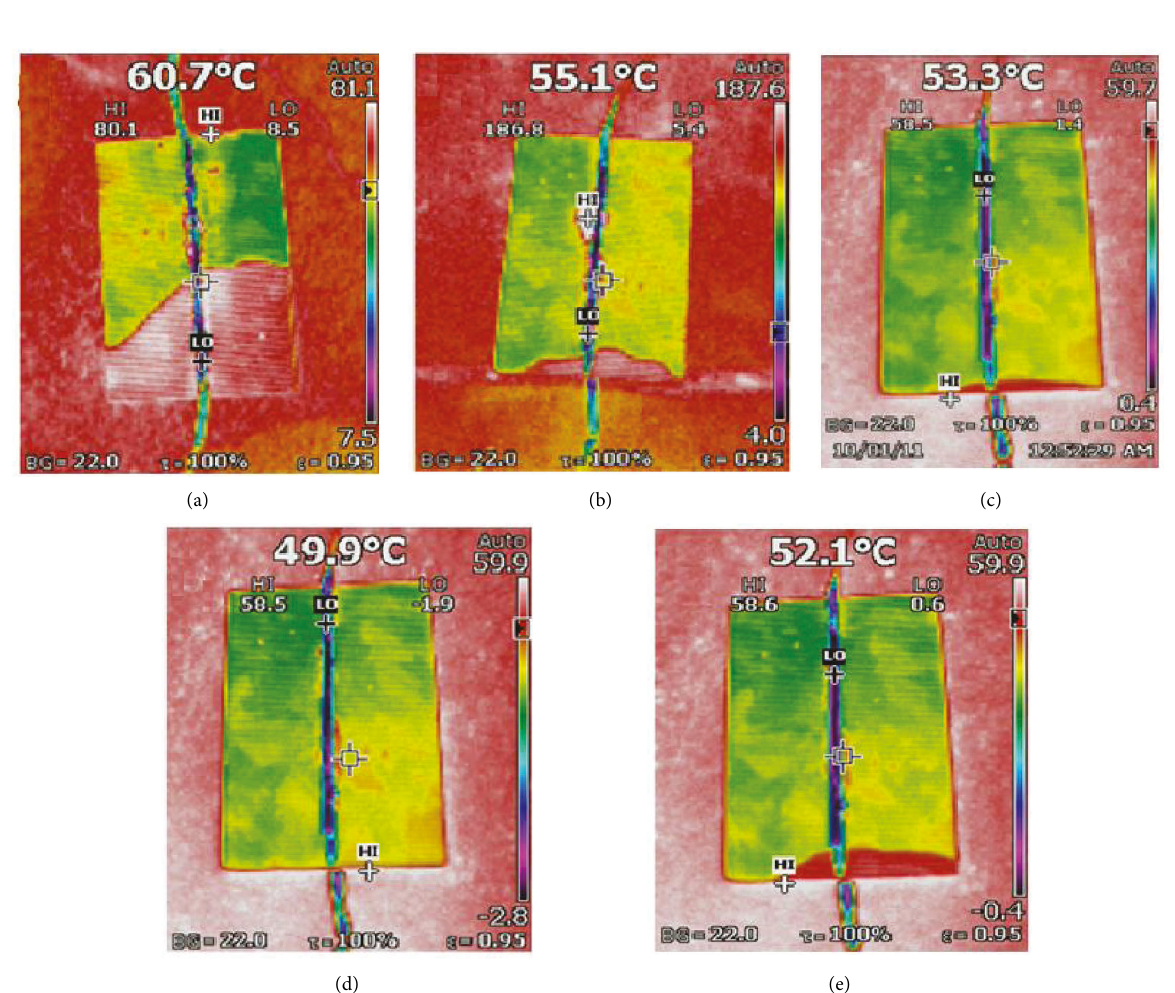
Figure 10: IR thermal imaging under a simulated light source (a) uncoated, (b) F1, (c) F2, (d) F3, and (e)